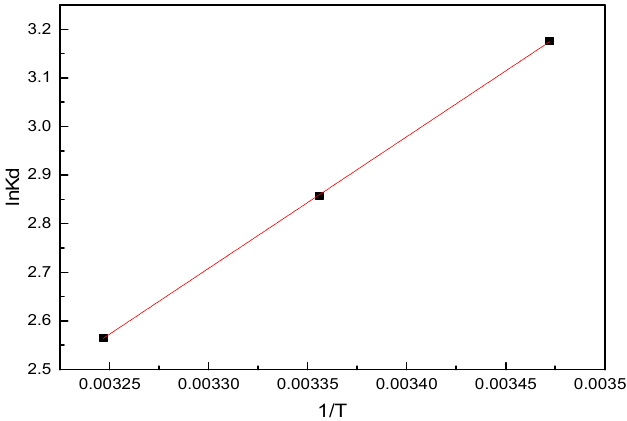
Figure 8. Adsorption thermodynamics of SL on 2.8%CB-LDH.